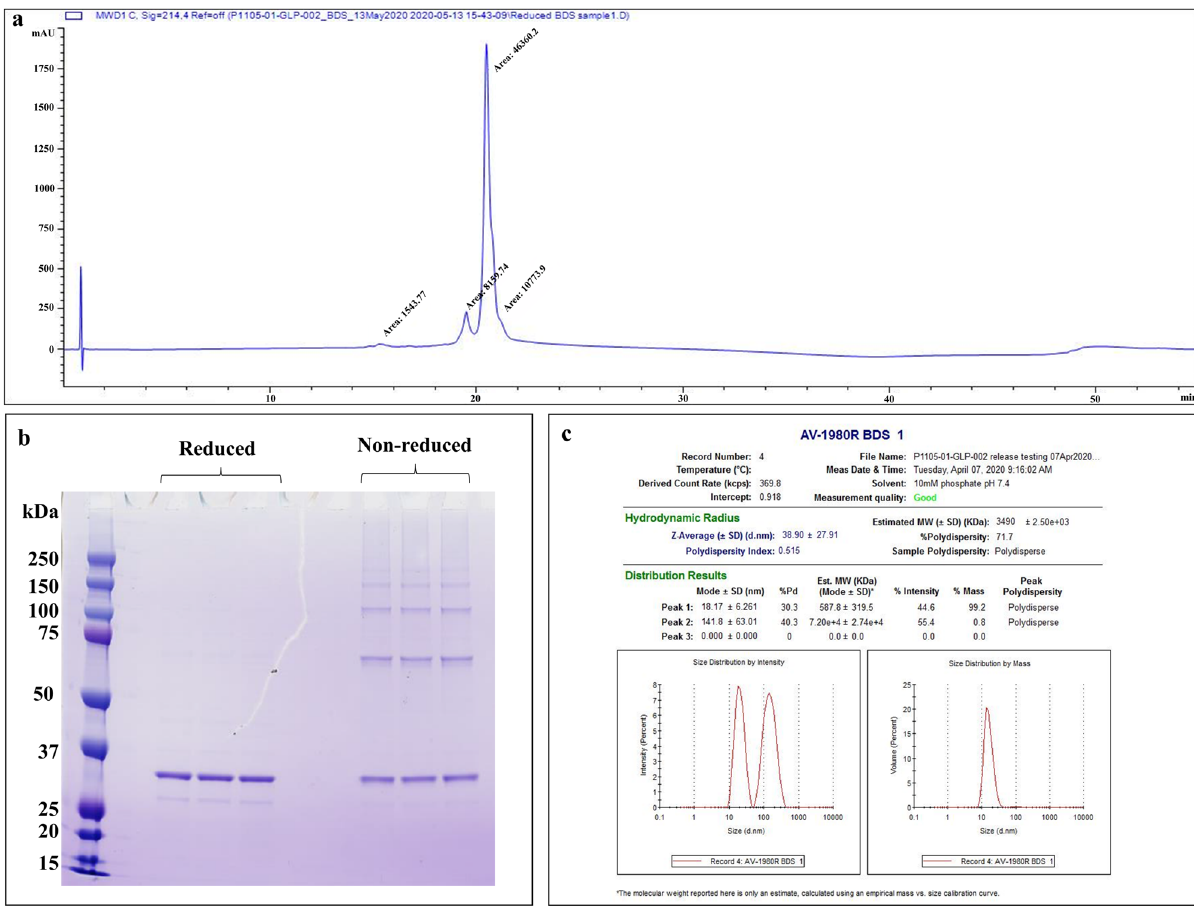
Fig. 2 Characterization of puri fi ed AV-1980R protein by RP-UPLC, SDS-PAGE assay, and DLS pro fi le. a Representative chromatogram from reverse-phase ultra-performance liquid chromatography (RP-UPLC): C4 2.1 x 50 mm, 1.7 μ m column; Mobile Phase A: 0.1% TFA in water; Mobile Phase B: 0.1% TFA in acetonitrile; Flow rate: 0.5 mL/min, Gradient 0 – 100%B over 37 min. b SDS-PAGE pro fi les of the AV-1980R protein in reduced and non-reduced conditions. The main band in all samples corresponds to the expected molecular weight of AV-1980R of 31.6 kDa. The numbers on the left side of the image correspond to the molecular weight of the standard in kilodaltons. c DLS pro fi le of AV-1980R, distribution by mass and